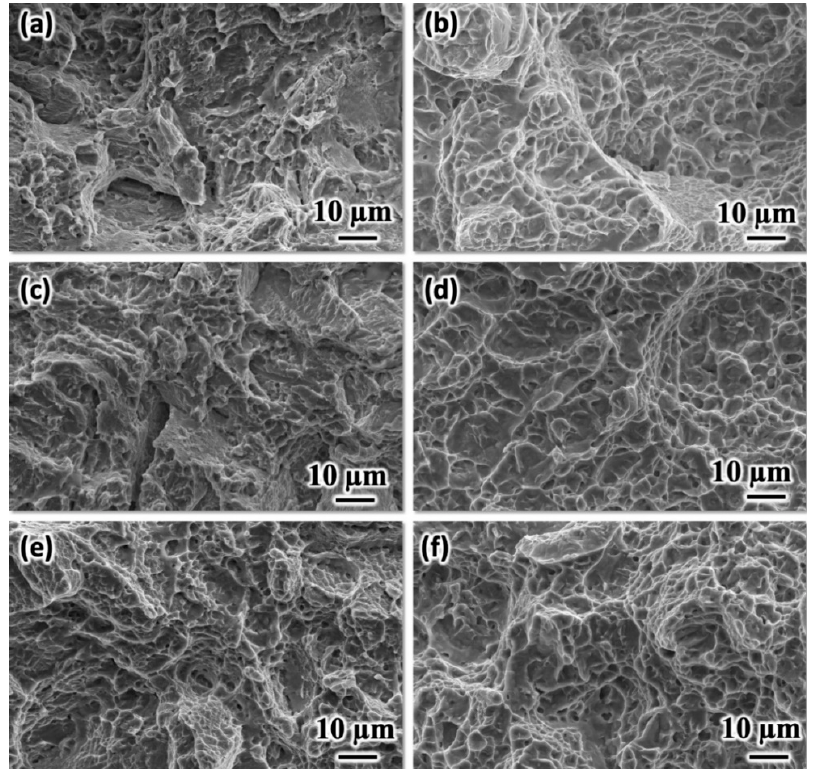
Figure 4. Secondary electron fractographic micrographs at higher magnification for Ti-6Al-4V ELI alloy samples after ASR and HIP: ( a ) ASR-A1, ( b ) HIP-A1, ( c ) ASR-B1, ( d ) HIP-B1, ( e ) ASR-C1, and ( f ) HIP-C1.